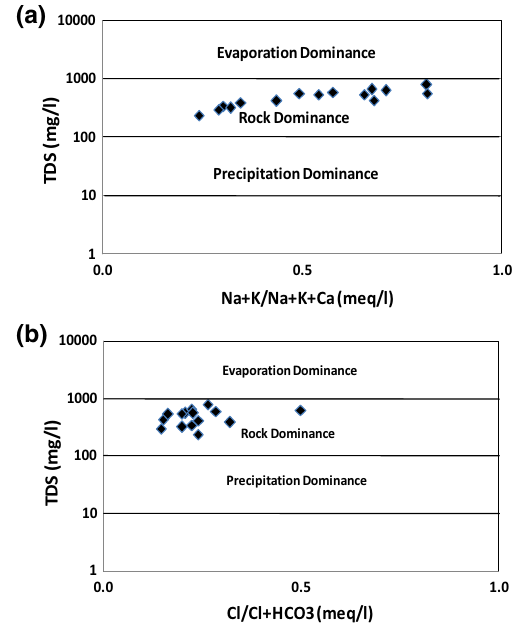
Fig. 4 Mechanism controlling groundwater chemistry (Gibbs 1970). a Gibbs ratio 1 (for cation), b Gibbs ratio 2 (for anion)